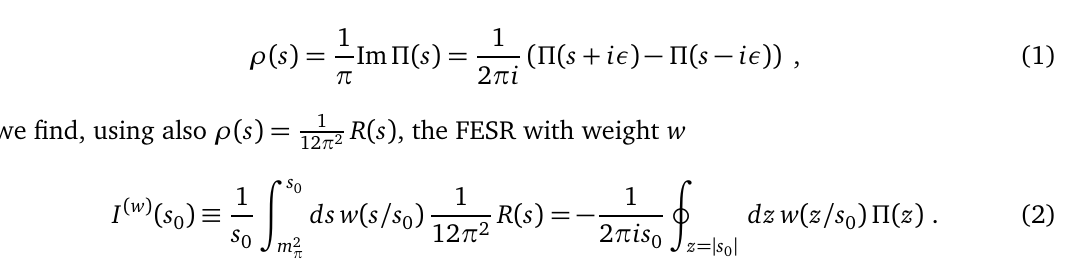
(see text). The solid curve shows the π